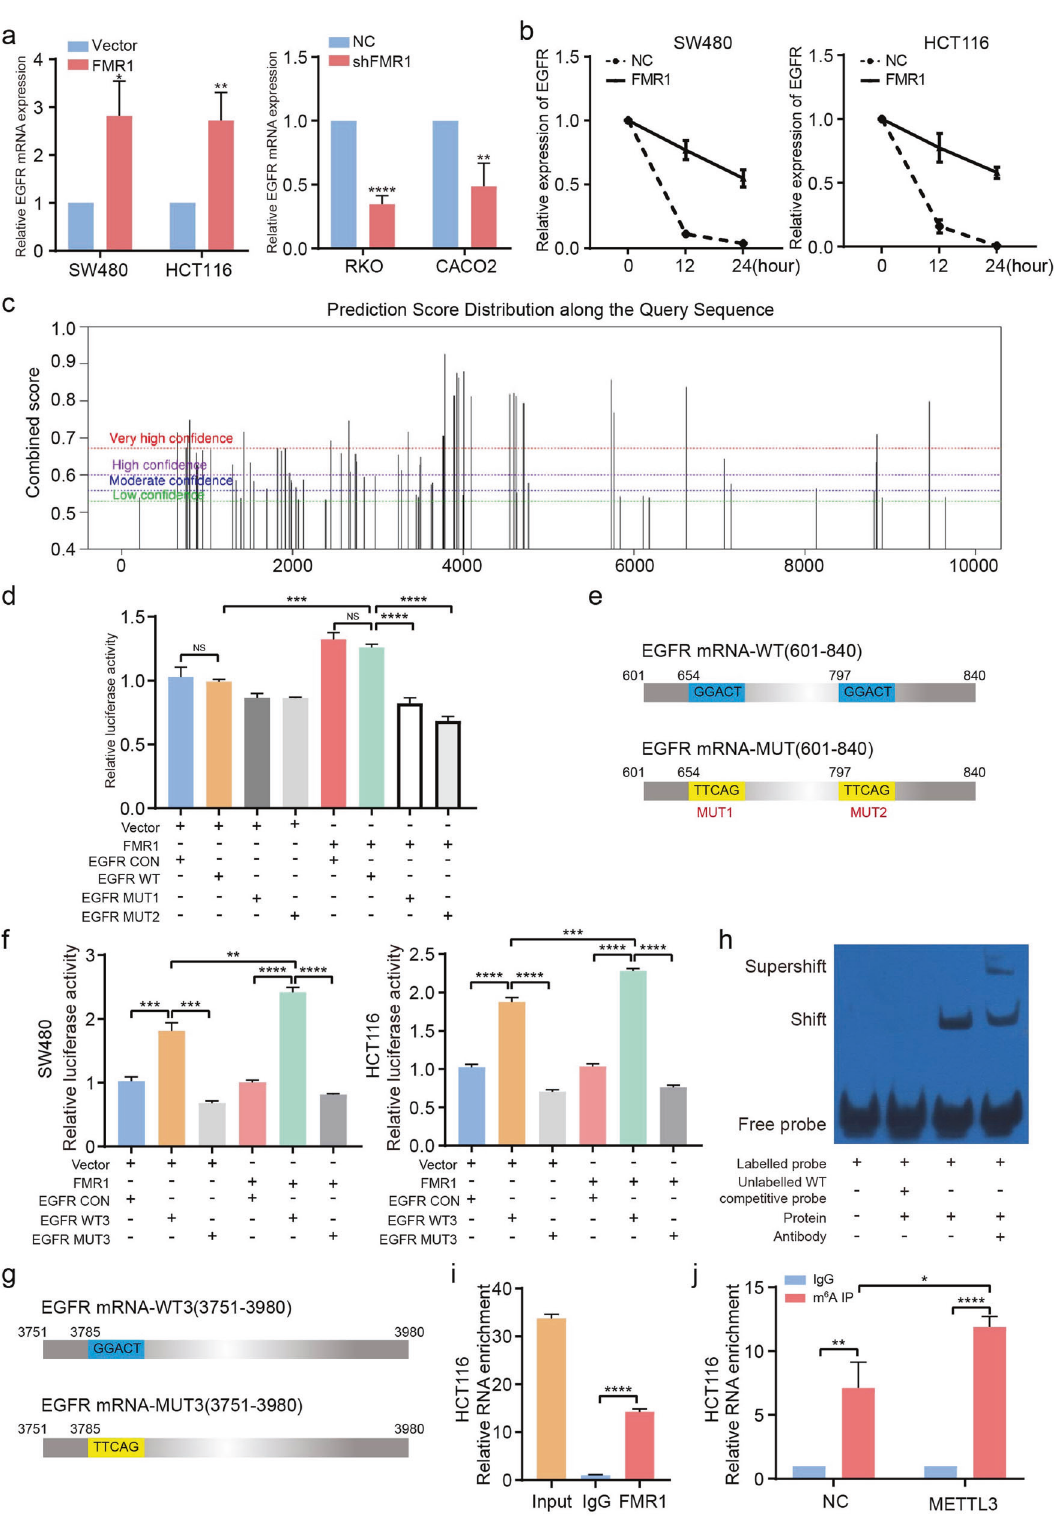
Fig. 5 FMR1 regulates EGFR mRNA stability via m 6 A-dependent manner. a RT-qPCR was used to test the expression of EGFR when FMR1 was stably overexpressed or knockdown. b RT-qPCR was used to test the stability of EGFR mRNA in the indicated CRC cells. c Prediction of speci fi c binding sites recognized by FMR1 protein on the EGFR mRNA sequence. d Luciferase activity assay showed that FMR1 protein in fl uences the luciferase activity of EGFR mRNA (654 and 797 position) in SW480 and HCT116 cells. e Schematic representation of wild-type (EGFR mRNA-wt) and mutant (EGFR mRNA-mut) EGFR mRNA constructs. f Luciferase activity assay showed that FMR1 protein in fl uences the luciferase activity of EGFR mRNA (3785 position which is locating on the EGFR 3'UTR) in SW480 and HCT116 cells. g Schematic representation of wild-type (EGFR mRNA-wt) and mutant (EGFR mRNA-mut) EGFR mRNA constructs. h The binding between FMR1 protein and EGFR mRNA (3785 position) was validated by RNA EMSA. i RIP-derived RNA in HCT116 cells were measured by RT-qPCR. j Gene-speci fi c m 6 A qPCR validation of m 6 A levels of EGFR mRNA (3785 position) in HCT116 cells. * P < 0.05,** P < 0.01, *** P < 0.001, **** P < 0.0001. NS not signi fi cant. Cell Death and Disease (2022)